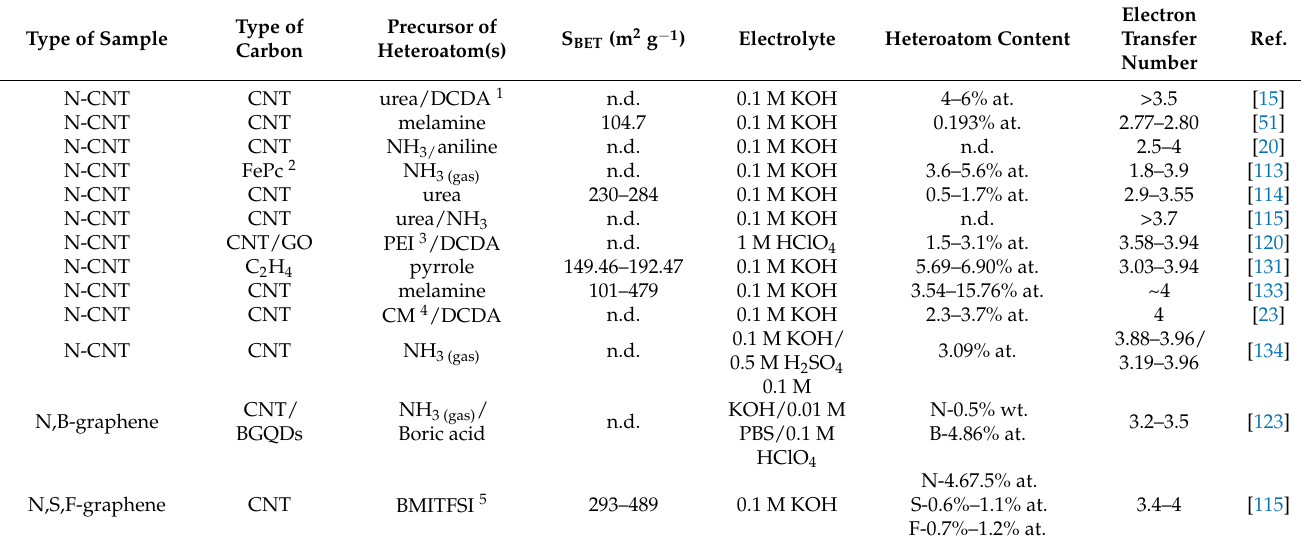
Table 4. Summary of nitrogen-doped carbon nanotubes synthesized via the pyrolysis as an electro- catalyst for